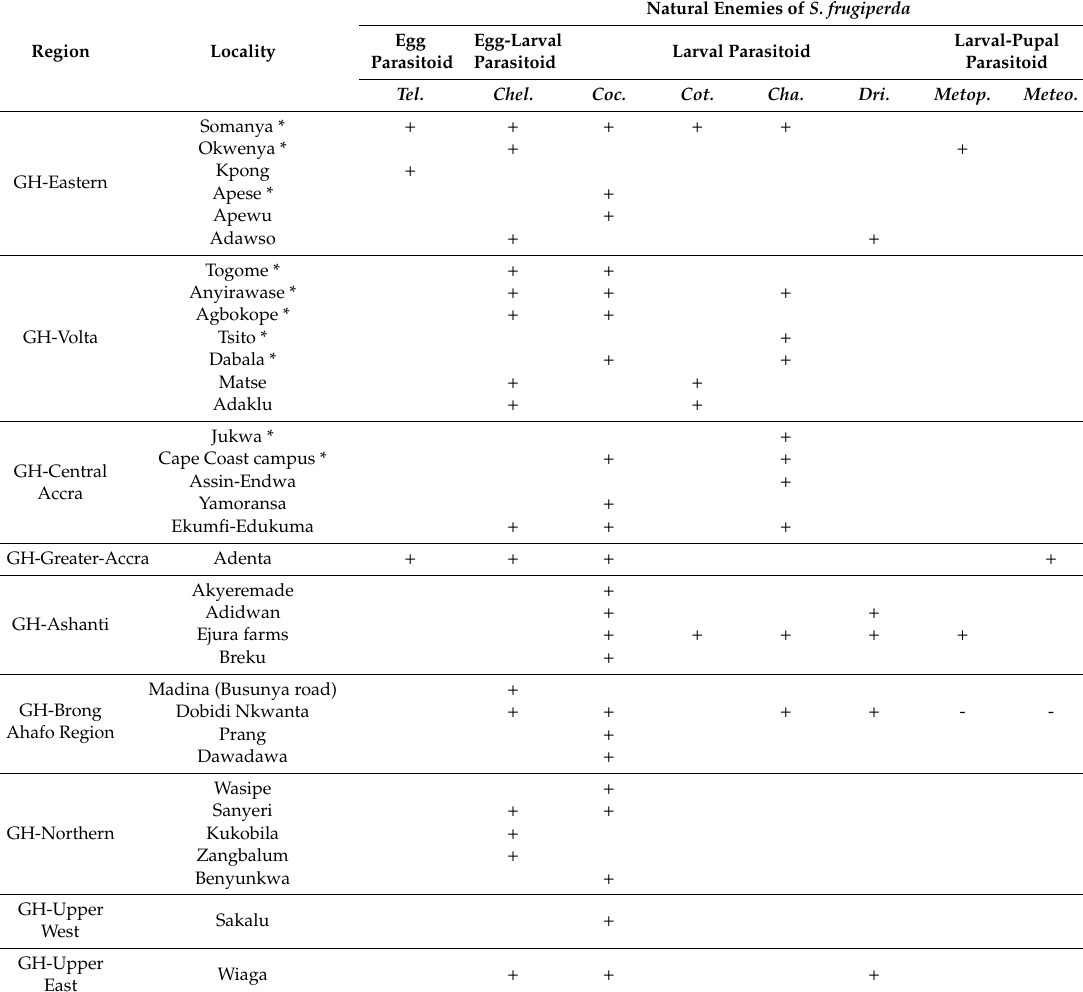
Table 2. Parasitoids of Spodoptera frugiperda in di ff erent localities of Ghana in 2018.